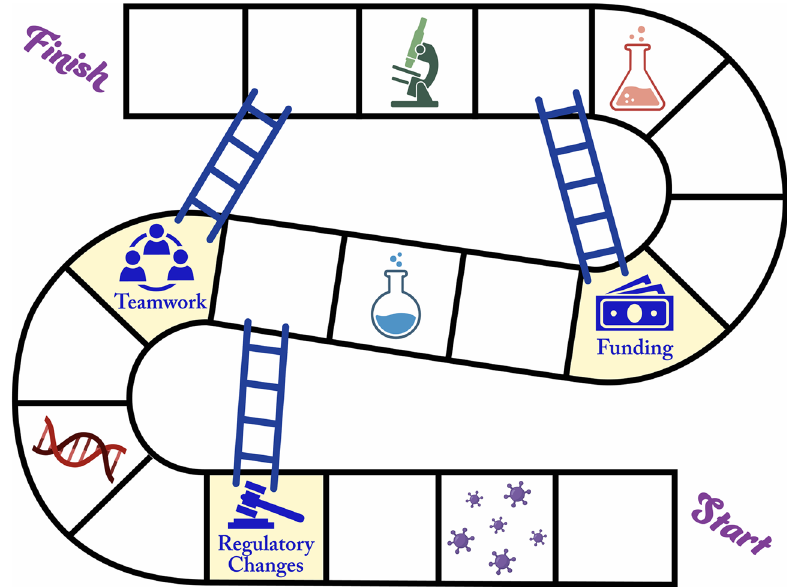
Fig. 1 Roadmap of technology translation. Translating a technology involves numerous steps. During the past year, several new paths were opened, accelerating this process. Created using icons from